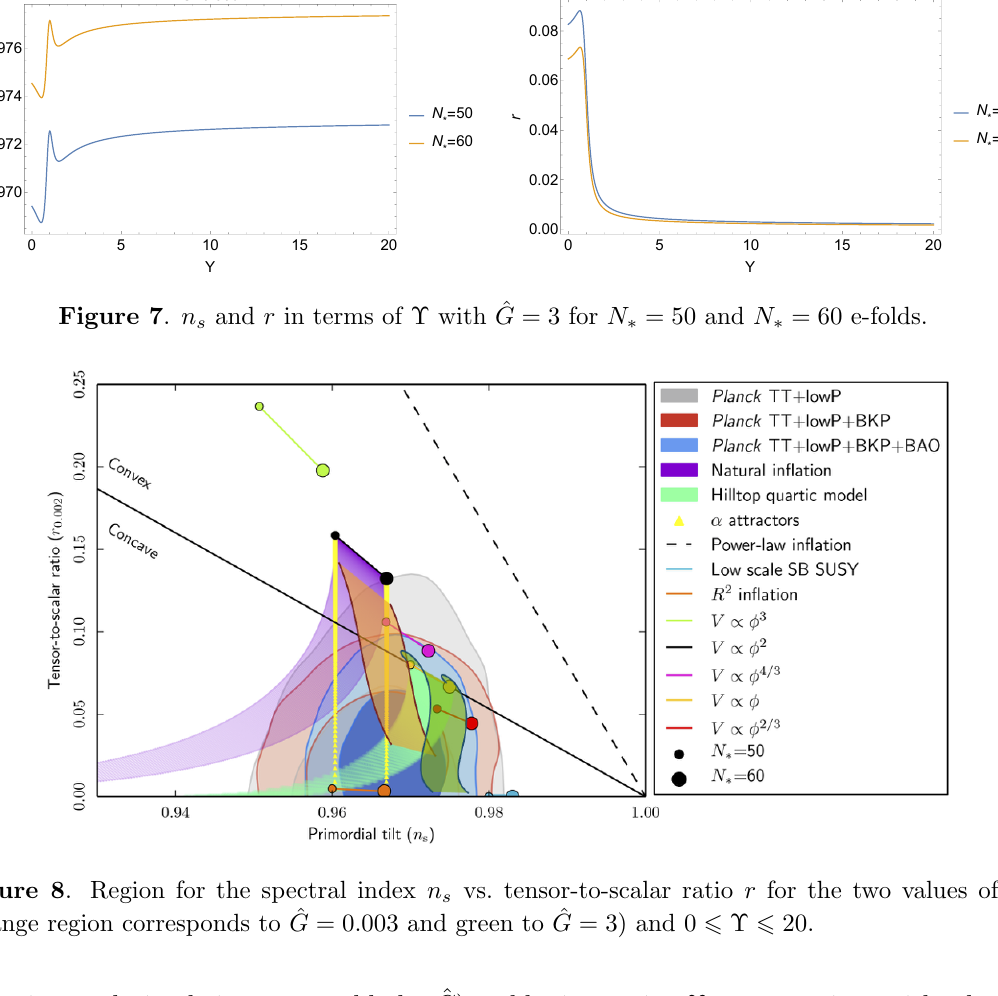
(cid:0) r plane, s